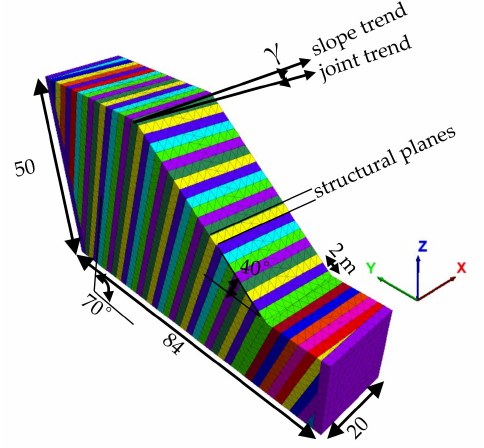
Figure 2. Three-dimensional view of the slope